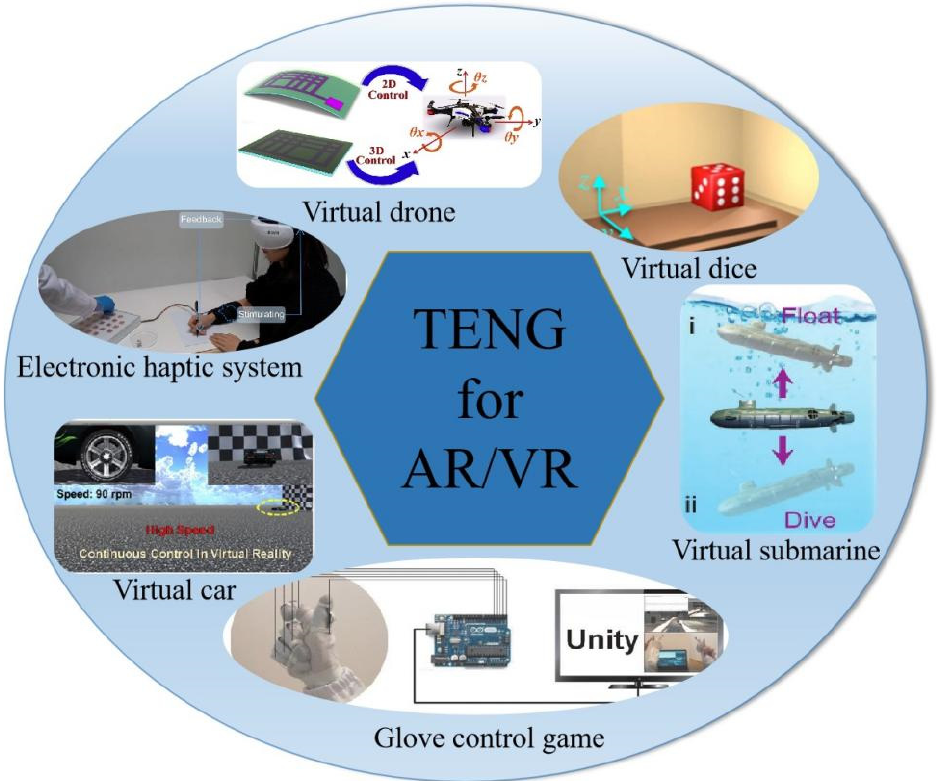
Figure 1. Application of TENG in AR and VR. Reprinted with permission from ref. [39]. Copyright